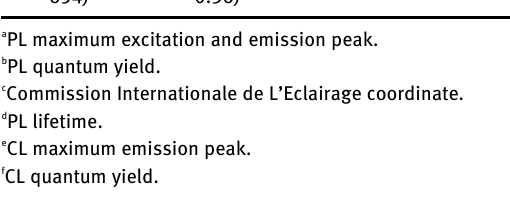
Figure 3b, one smooth CL kinetic curve in one cycle can be measured by the instrument using the CDs as CL probe.